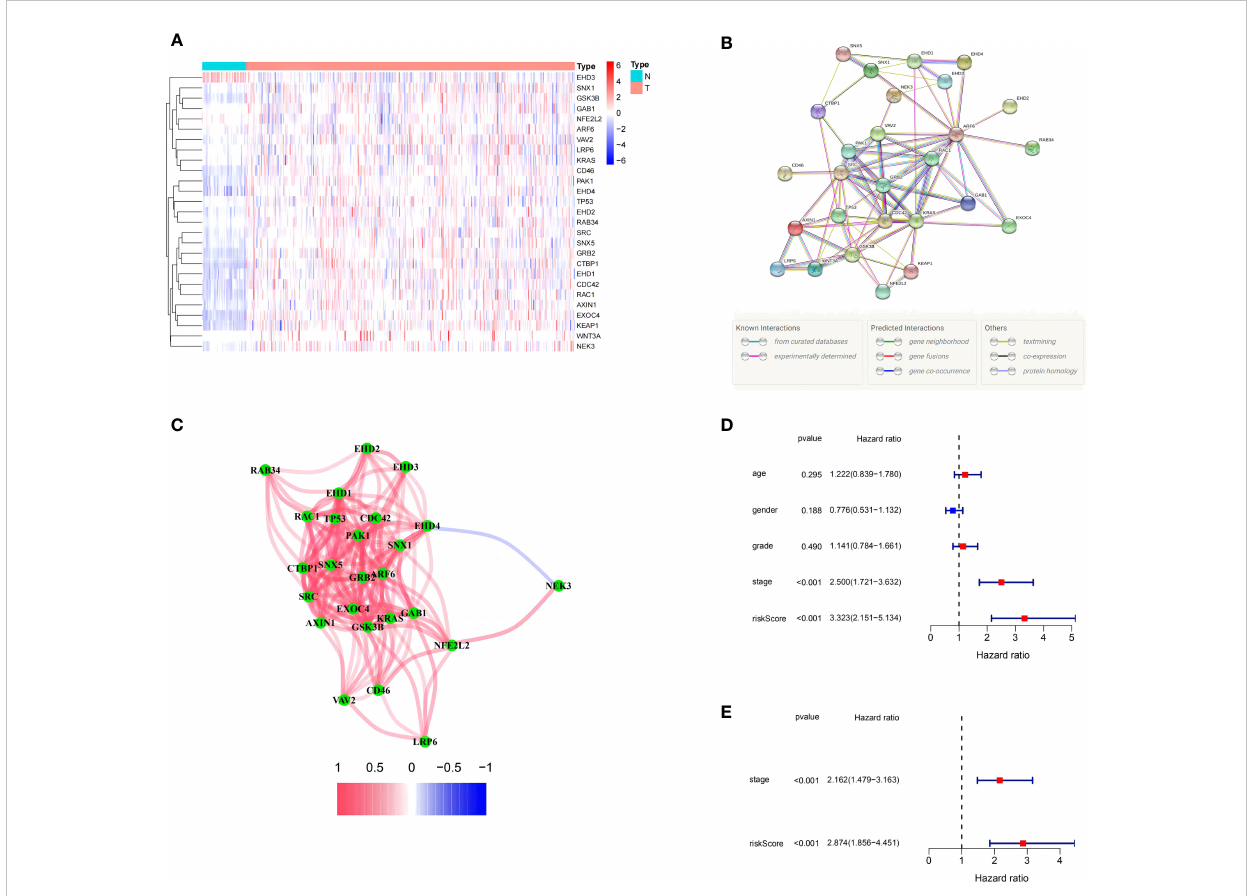
FIGURE 1 Expression of the 27 differentially expressed macropinocytosis-related genes (DEMRGs) and their interactions. (A) Heatmap (blue: low expression level; red: high expression level) of the DEMRGs between the non-tumor (N, blue) and tumor (T, red) samples. (B) The PPI network showing the interactions of the DEMRGs (interaction score = 0.4). (C) The correlation network of the DEMRGs (red line: positive correlation; blue line: negative correlation. The depth of the colors re fl ects the strength of the association). (D, E) Univariate and multivariate Cox regression analyses for the risk score. (D) Univariate analysis for the TCGA cohort. (E) Multivariate analysis for the TCGA